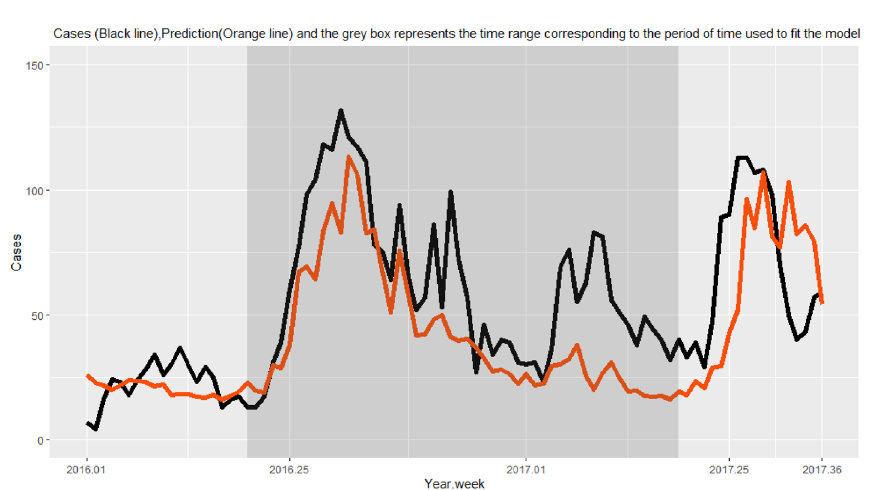
Figure 7. Cumulative number of reported cases (black line) and predicted cases (orange line) in 27 villages of South-Western Burkina Faso using a meteorological